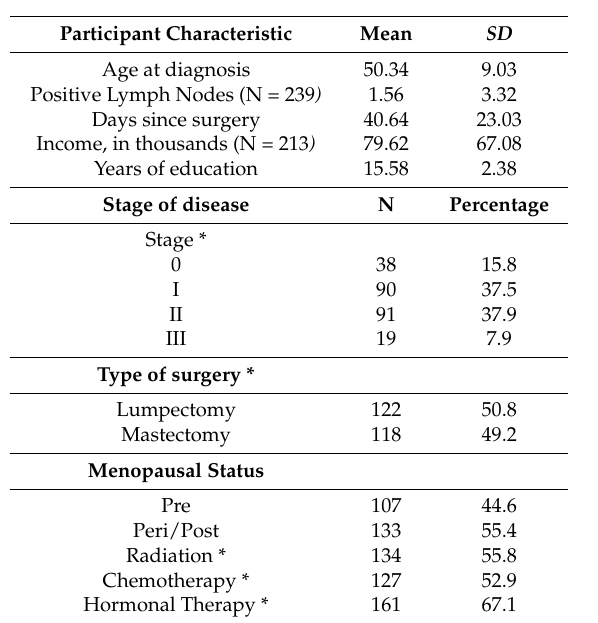
Table 1. Demographic and medical variables collected at study-entry. N = 240 unless otherwise